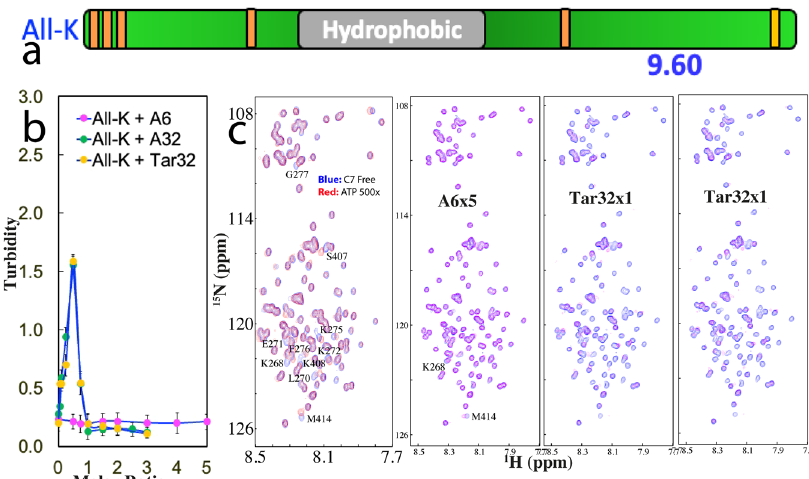
Fig. 2 Three ssDNAs bind to Arg with the af fi nity higher than that to Lys. a Schematic representation of AllK-PLD with all fi ve Arg mutated to Lys. b Turbidity curves of AllK-PLD in the presence of Tar32, A6 and A32 at different molar ratios. c HSQC spectra of AllK-PLD in the absence (blue) and in the presence of ATP at a molar ratio of 1:500 (red), as well as A6 at 1:5, A32 and Tar32 at 1:1 (purple)